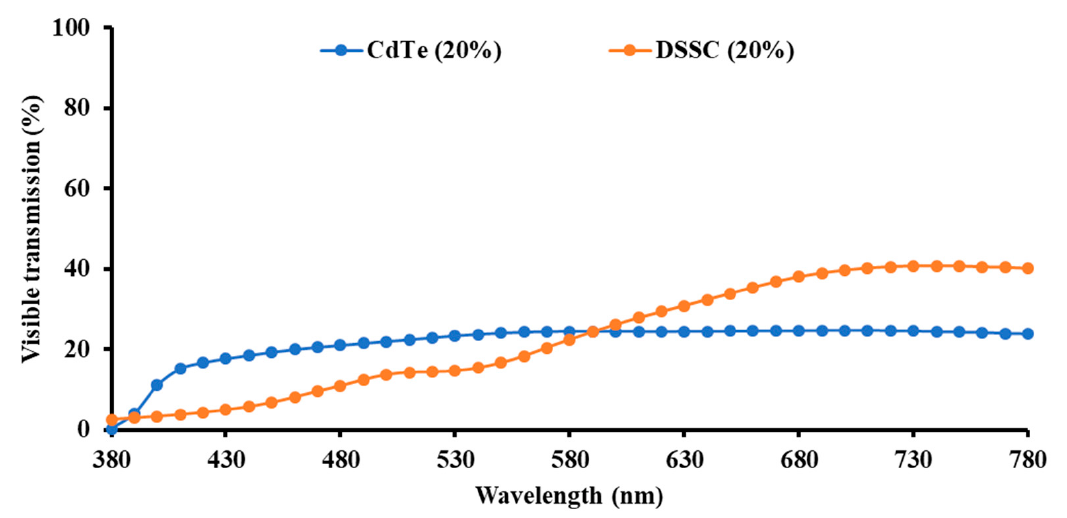
Figure 4. Wavelength dependent visible transmission for 20% CdTe [50], DSSC 20% [51]. Graphs are reproduced from [50,51]. Reprint with permission [50,51], 2021, Elsevier.